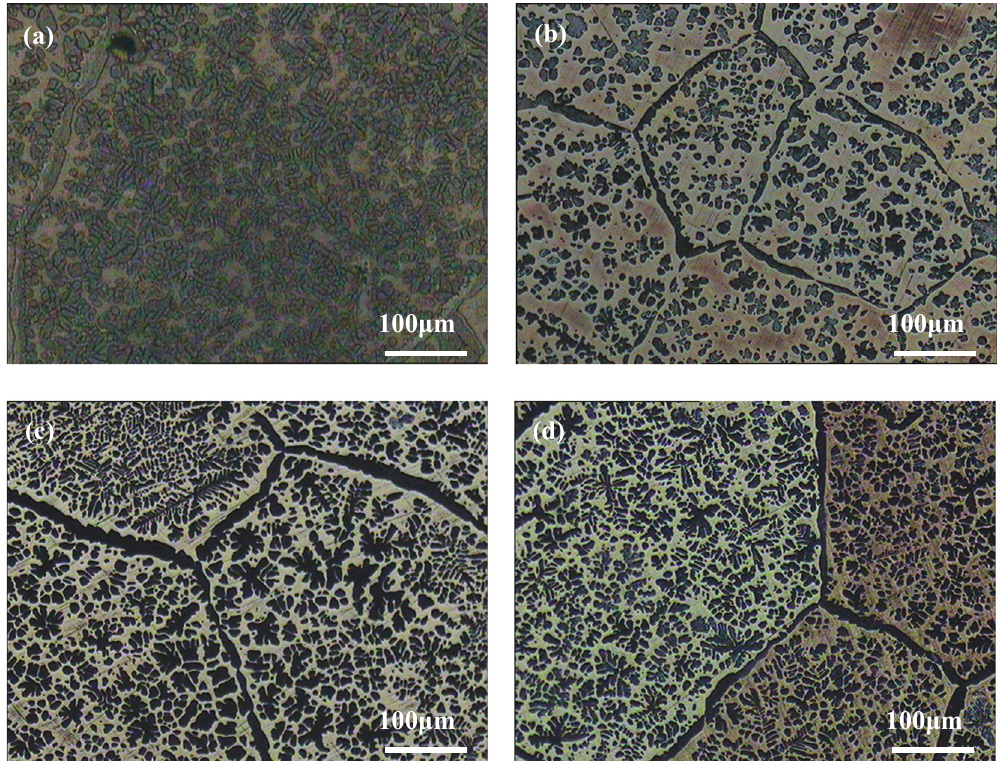
Figure 1: Microstructure of brass alloy with and without EPT ( a ) original sample, ( b ) 3 Hz, ( c ) 8 Hz and ( d ) 15 Hz.